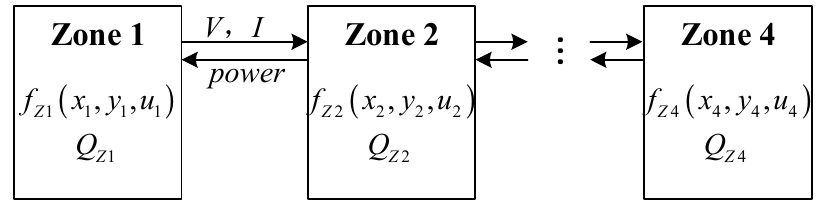
Figure 3. Inter-dependency of the zones.